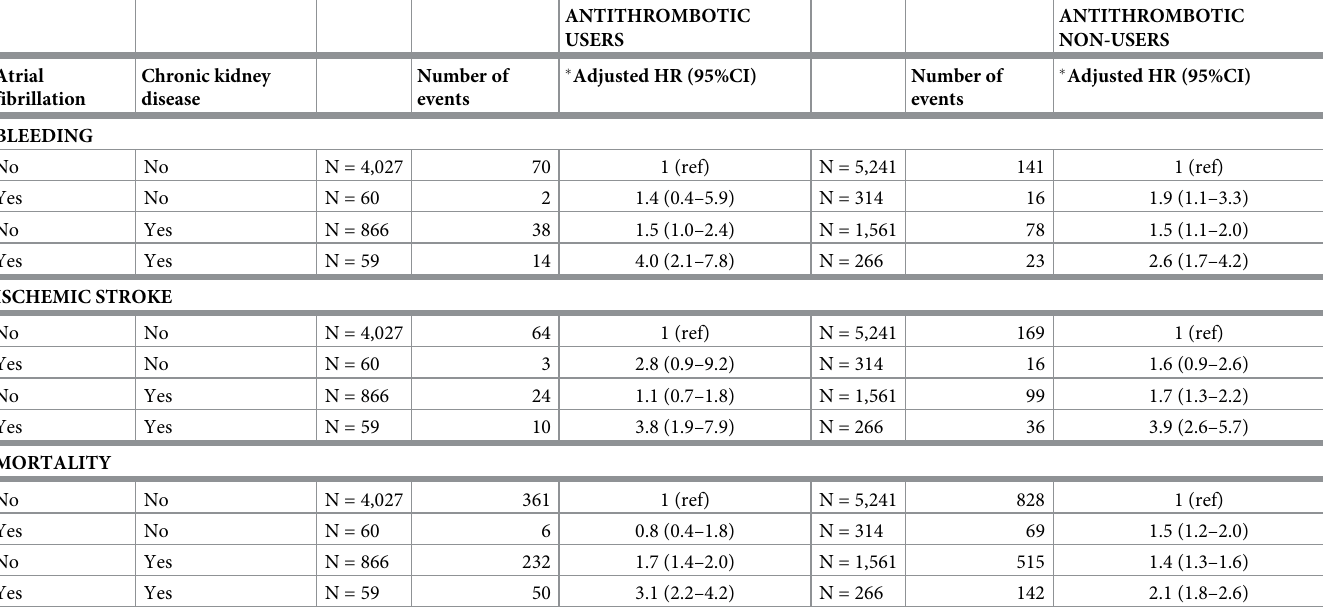
ANTITHROMBOTIC USERS